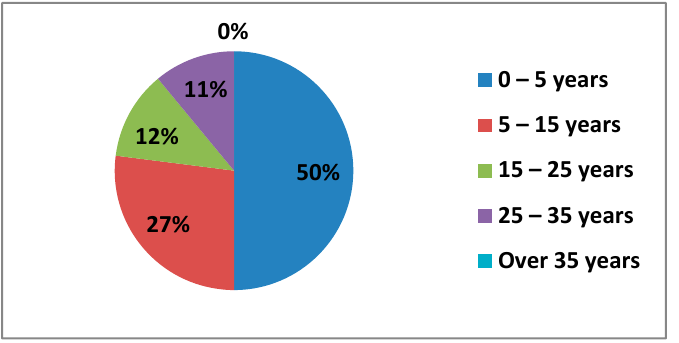
Figure 6. Teaching experience.